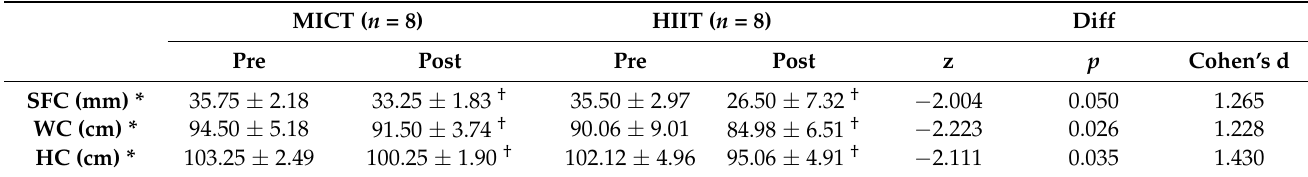
Table 4. Responses on abdominal obesity for MICT and HIIT groups.